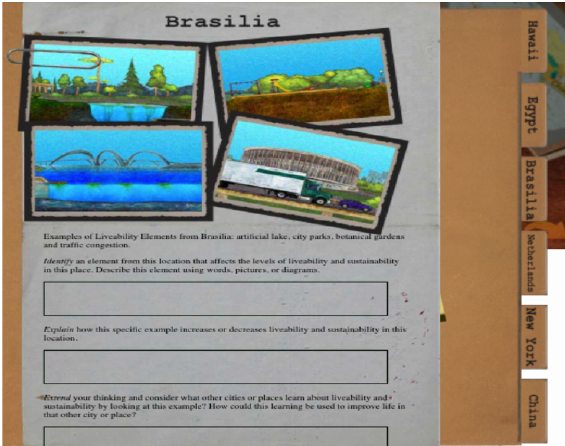
Figure 10. Human systems activity.